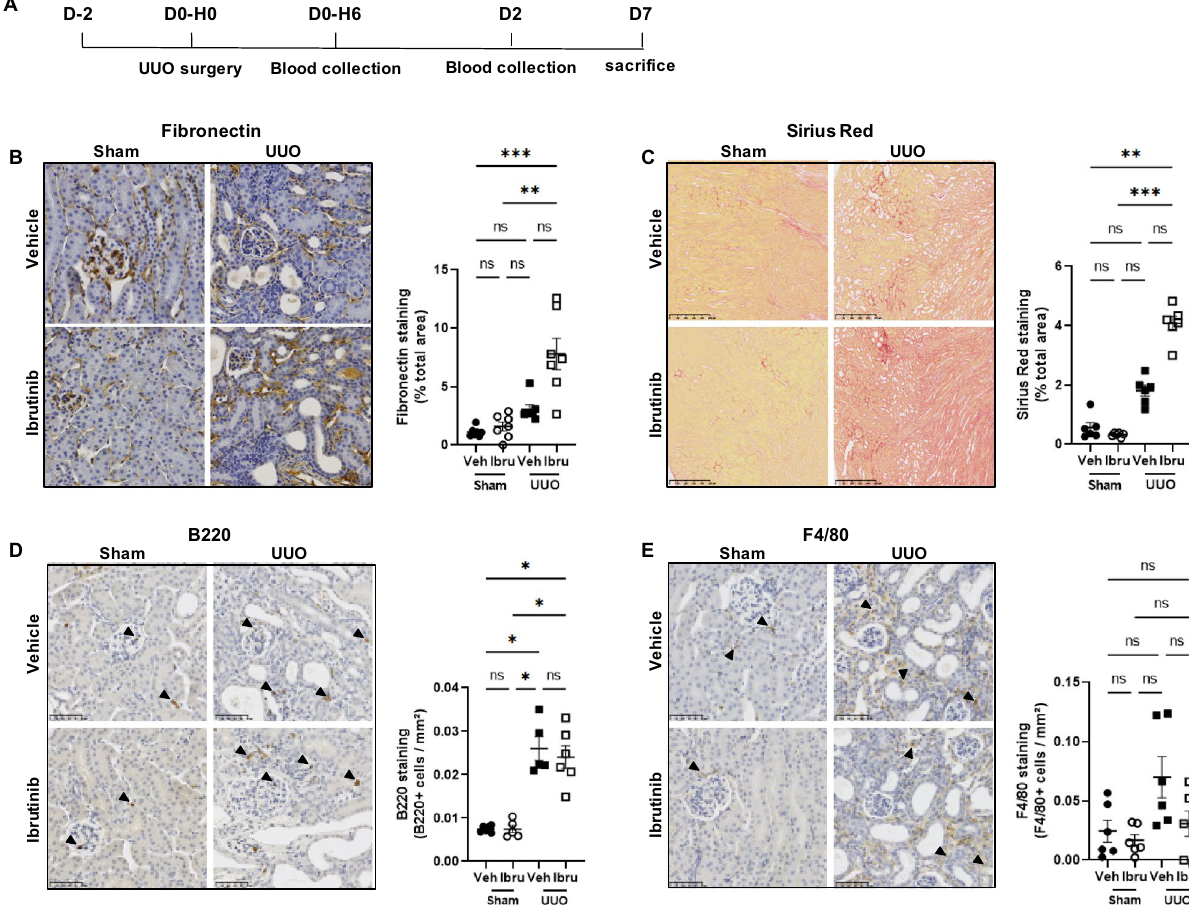
Figure 1. Ibrutinib promotes renal fibrosis after unilateral ureteric obstruction (UUO). ( A ) Design of the study. ( B – E ) Representatives images and quantifications of Fibronectin ( B ), Sirius Red ( C ), B220 ( D ) and F4/80 ( E ) staining in sham and UUO mice receiving ibrutinib (Ibru) or vehicle (Veh). Data are represented as means ± SEM. *p < 0.05 (Mann–Whitney test; n = 6 mice per group); ns, not